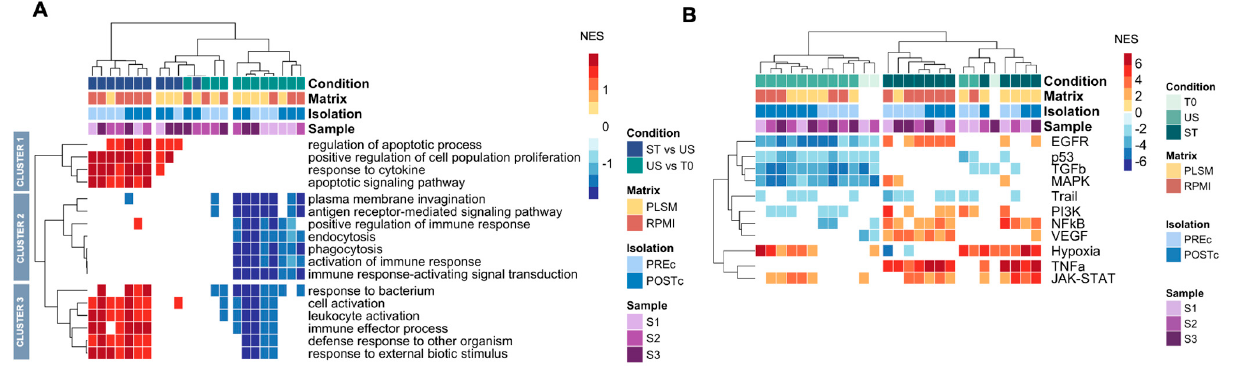
Figure 4. GSEA on Biological processes and inference of the pathway activity. Heatmap shows Normalized Enriched Score (NES) values from GSEA on biological processes between ST vs. US and US vs. T0 comparisons. Positive values (red) indicate biological processes enriched in up-regulated genes. Conversely, negative values (blue) show processes enriched in down-regulated genes. White indicates the absence of significant results ( A ). VIPER analysis to infer pathway activity in a single sample’s transcriptome. Active pathways are shown in red, inactive pathways are shown in blue, and pathways with no significant results are shown in white ( B ).